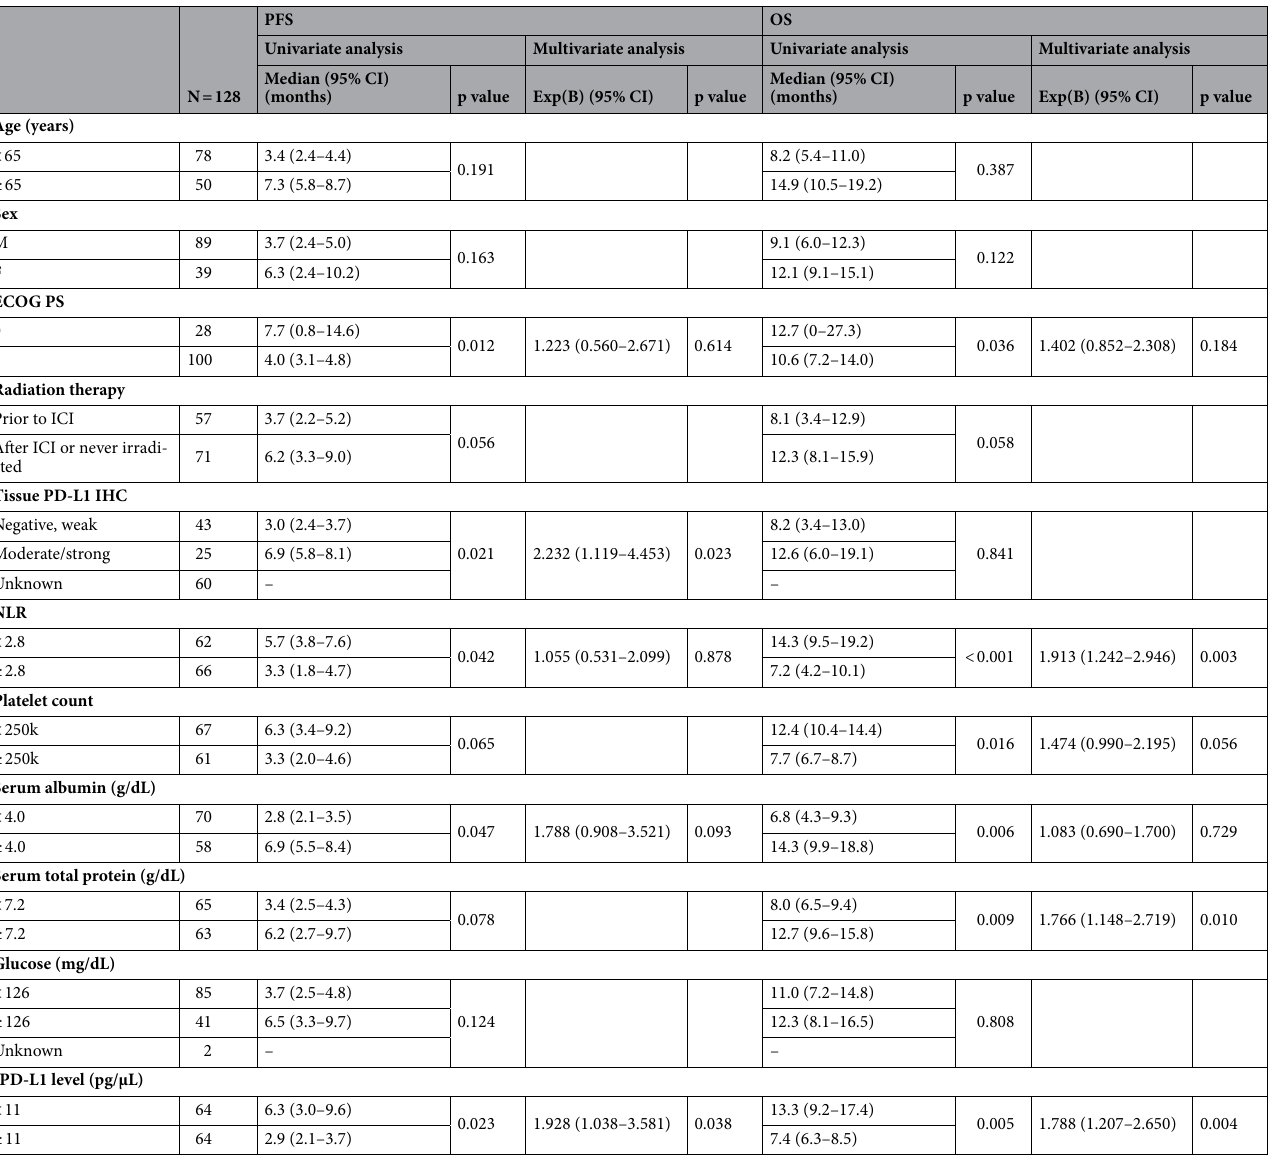
Table 3. Univariate and multivariate analysis of PFS and OS* PFS progression-free survival, OS overall survival, CI confidence interval, ECOG PS eastern cooperative oncology group performance status, ICI immune checkpoint inhibitor, PD-L1 programmed death ligand-1, IHC immunohistochemical stain, NLR neutrophil to lymphocyte ratio, sPD-L1 soluble programmed death ligand-1. *Significant when p value is less than 0.05. Variables with p < 0.05 were examined in the multivariate